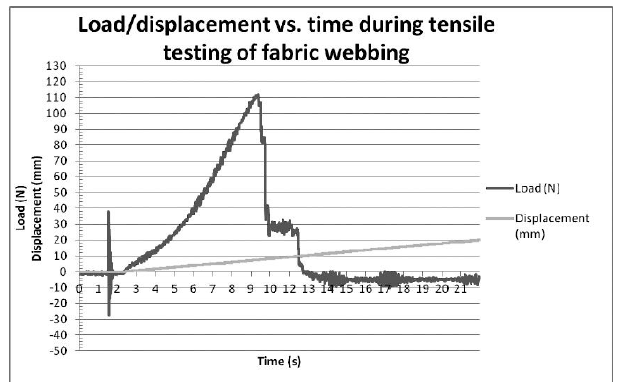
Figure5. Plot of load and displacement against time of baseline test 2 using fabric webbing. Initial data spike from “tapping” of load cell for data synchronisation point clearly captured.